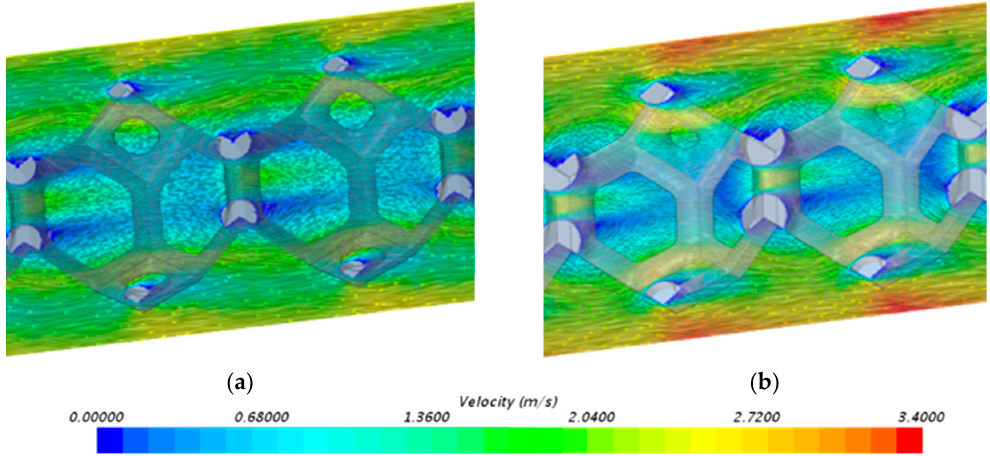
Figure 10. The comparison of velocity in different porosities: ( a ) Porosity of 0.85, ( b ) porosity of 0.75.